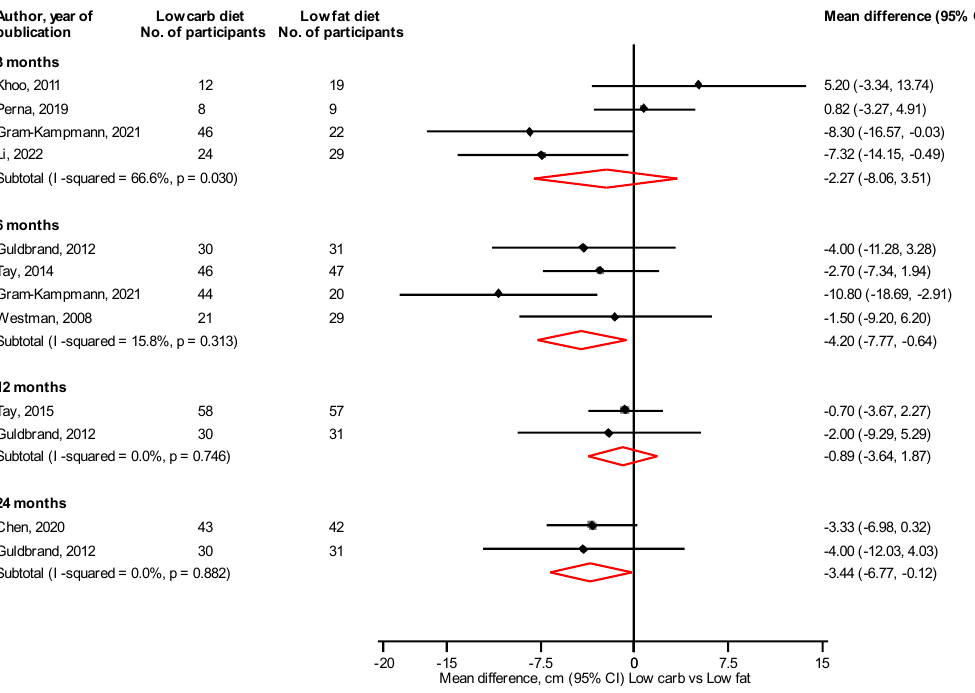
Figure 6. Low carbohydrate versus low fat diet and waist circumference [31,35,38,41,48,50,52–54].